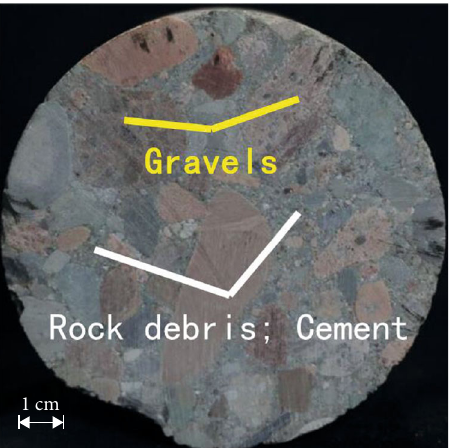
Figure 1: Rock conglomerate core. The core in the picture is 10cm in diameter and comes from a reservoir with a depth of more than